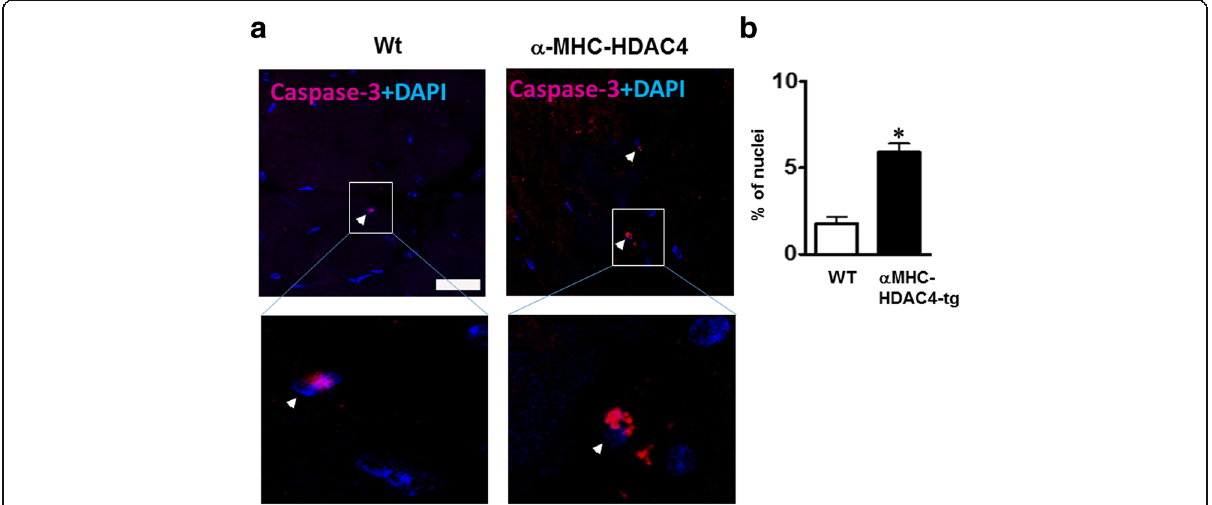
Fig. 7 Immunostaining detecting active caspase-3 in myocardium. a Immunostaining showing the increase of active caspase-3 positive signals in HDAC4-Tg mice vs wild type littermates. b Percentage of active caspase-3 positive nuclei in the myocardium following I/R. Values represent mean±SE ( n =3 per group); Scale bar=10 μ